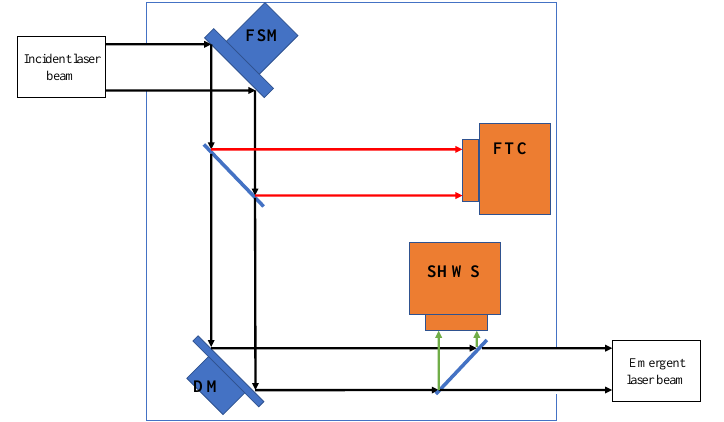
Figure 1. Proposed AO